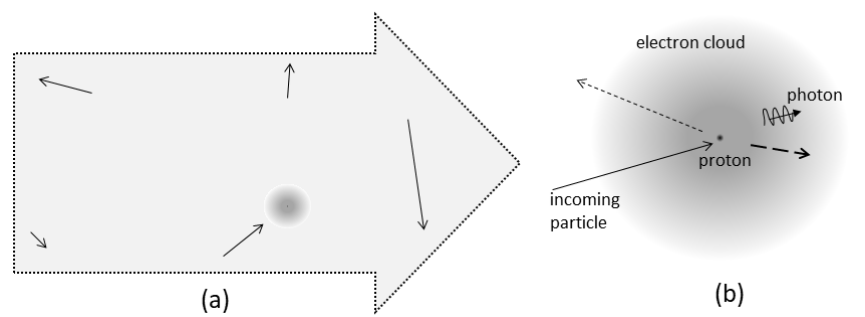
Figure 5. Schematics of collisions in a gas of NBDM: ( a ) section of the halo that is spinning (grey arrow) around the galaxy. The atom (spot) is immense compared to the particles (thin black arrows), o ff ering a large cross section; ( b ) collision of particle with an H atom. The nucleus is the draw, which has > 10 4 × more mass. Distortions of the nucleus or of the electron cloud during the collision result in emission of a photon as the particle and atom each rebound (dotted arrows).